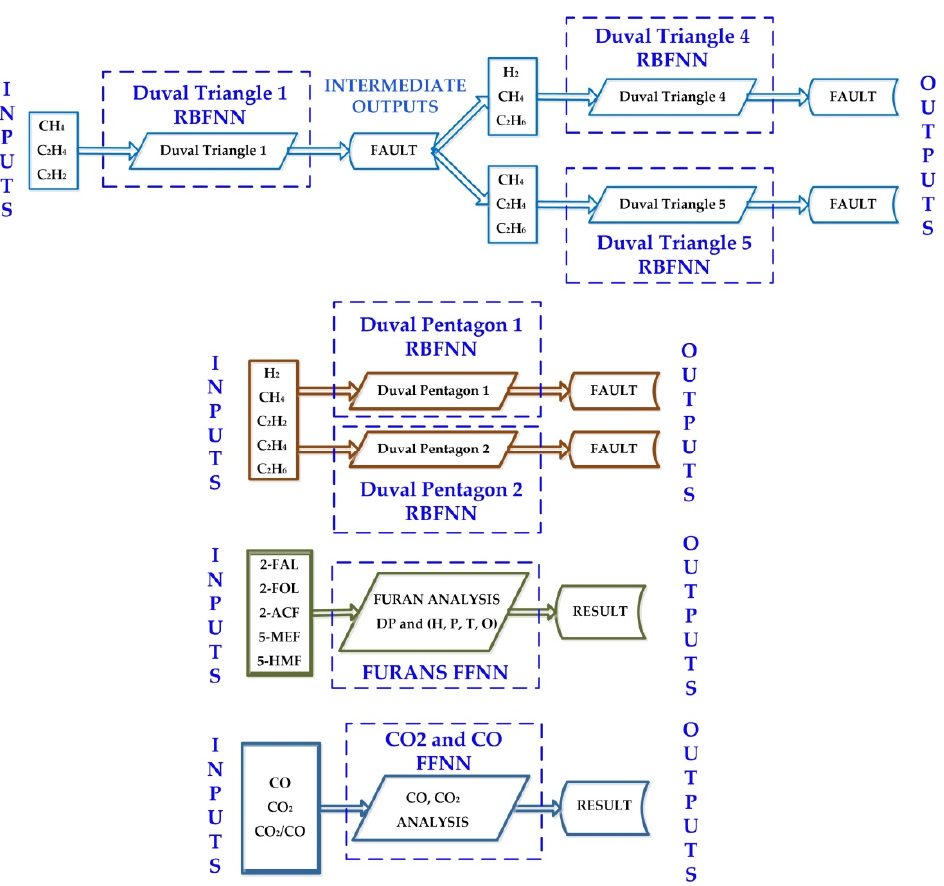
Figure 5. General flow chart of the ISDFPT-NN.